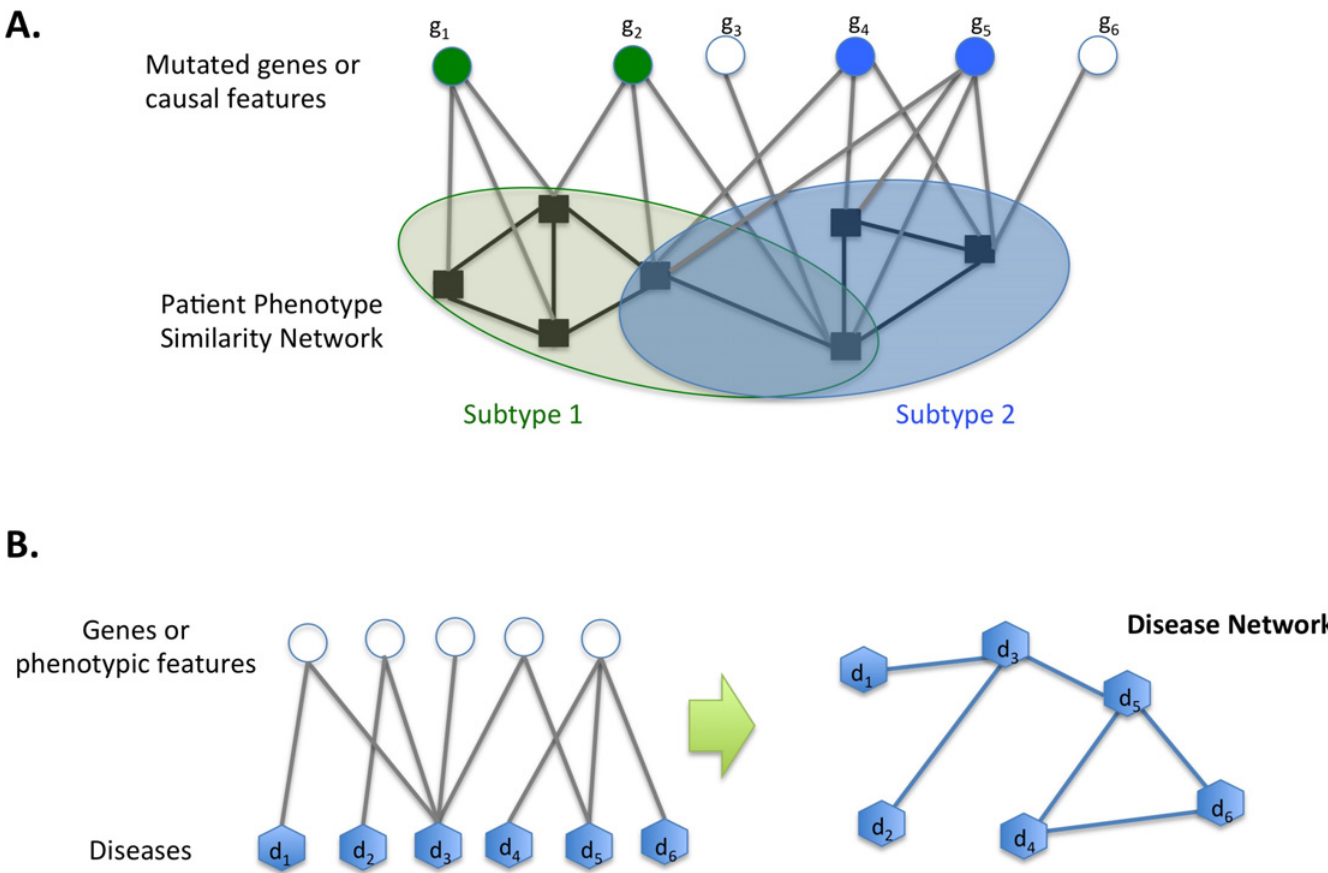
Fig 2. Other types of biological networks. A) Topic model utilizing a patient similarity network. The network guides to find disease subtypes and their features (in the figure, the mutations in genes g 1 and g 2 are selected features for Subtype 1, while Subtype 2 has mutations in g 4 and g 5 ). Patients can be represented as mixtures of multiple subtypes. B) Disease network. A disease network can be constructed based on shared disease genes or the similarity of disease phenotypes. For example, the disease network on the right has an edge between two diseases if they share the same disease genes or phenotype